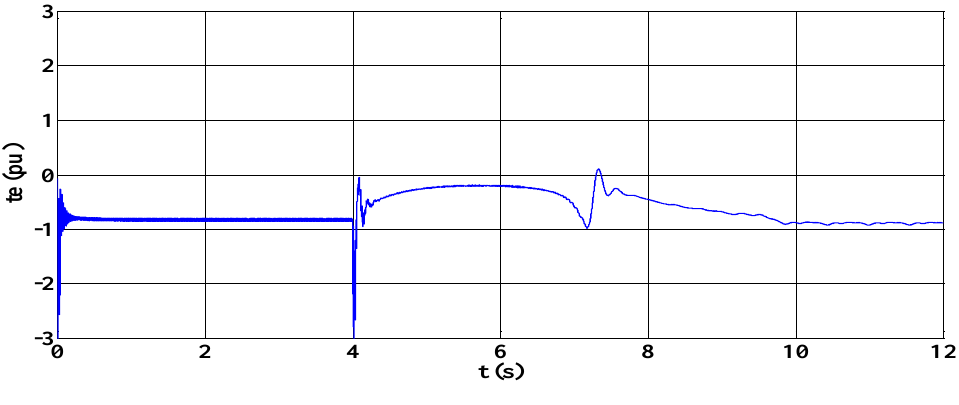
Figure 30. Electromagnetic torque (short-circuit happens at t = 4 s).